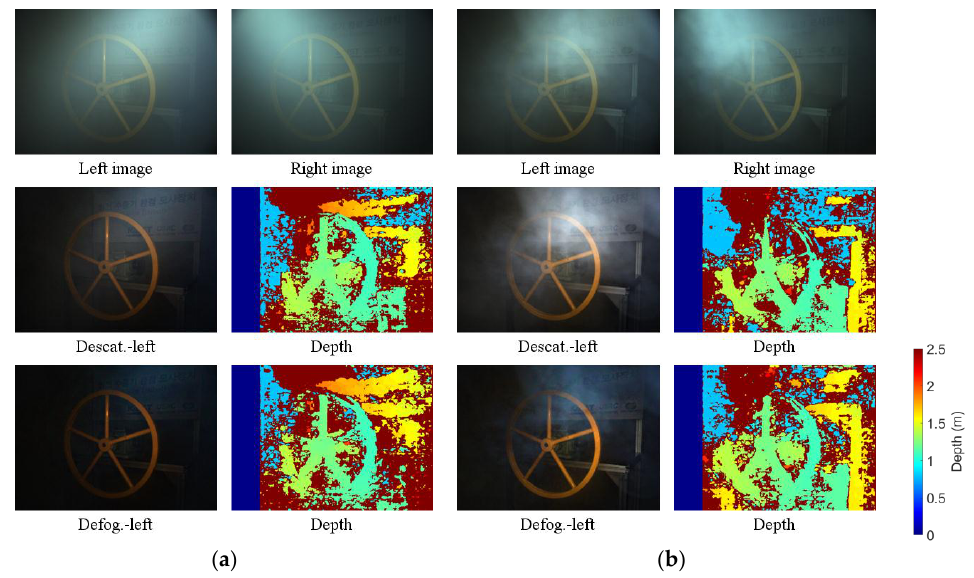
Figure 7. Experimental results; the stereo method is SGM: ( a ) Lighting 2—uniform fog of V = 2.4 m; ( b ) Lighting 2—non-uniform fog. The first row is corrupted images; the second and third row are descattered and defogged images, respectively.